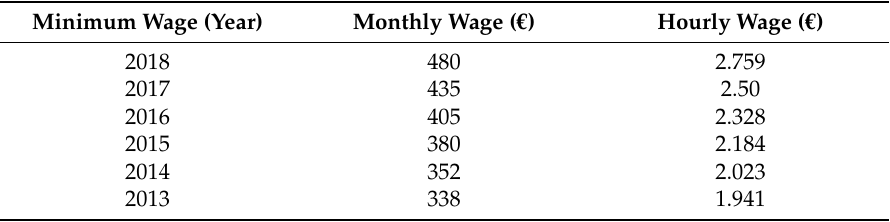
Table 1. The minimum wage overview in the Slovak